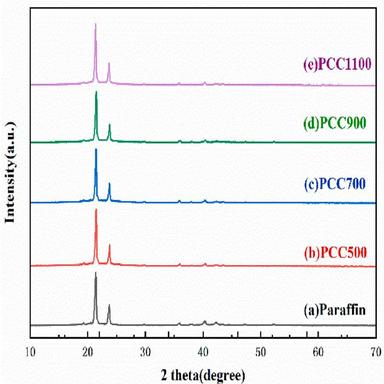
XRD patterns of Paraffin and PCCs.